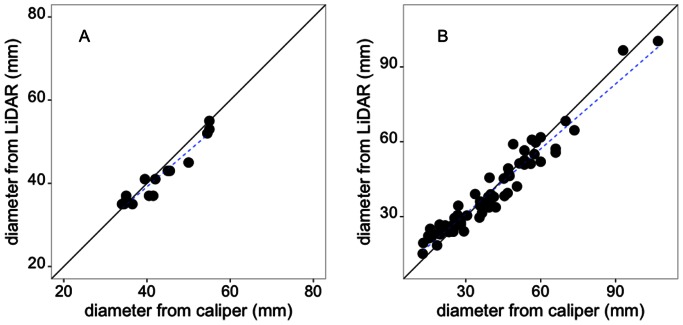
Comparison of the fidelity of terrestrial laser scanning estimates of the diameter of wooden dowels (A) and branches (B) with an ice coating.Branch and dowel diameter was measured using a caliper in the field and diameters for the same locations on branches were also extracted from terrestrial laser scanning point clouds. The solid line indicates a 1∶1 relationship and the dotted line the fitted relationship. Note: Model coefficients and summary statistics presented in Table 2. Timing of terrestrial laser scanning scanning given in Table 1.